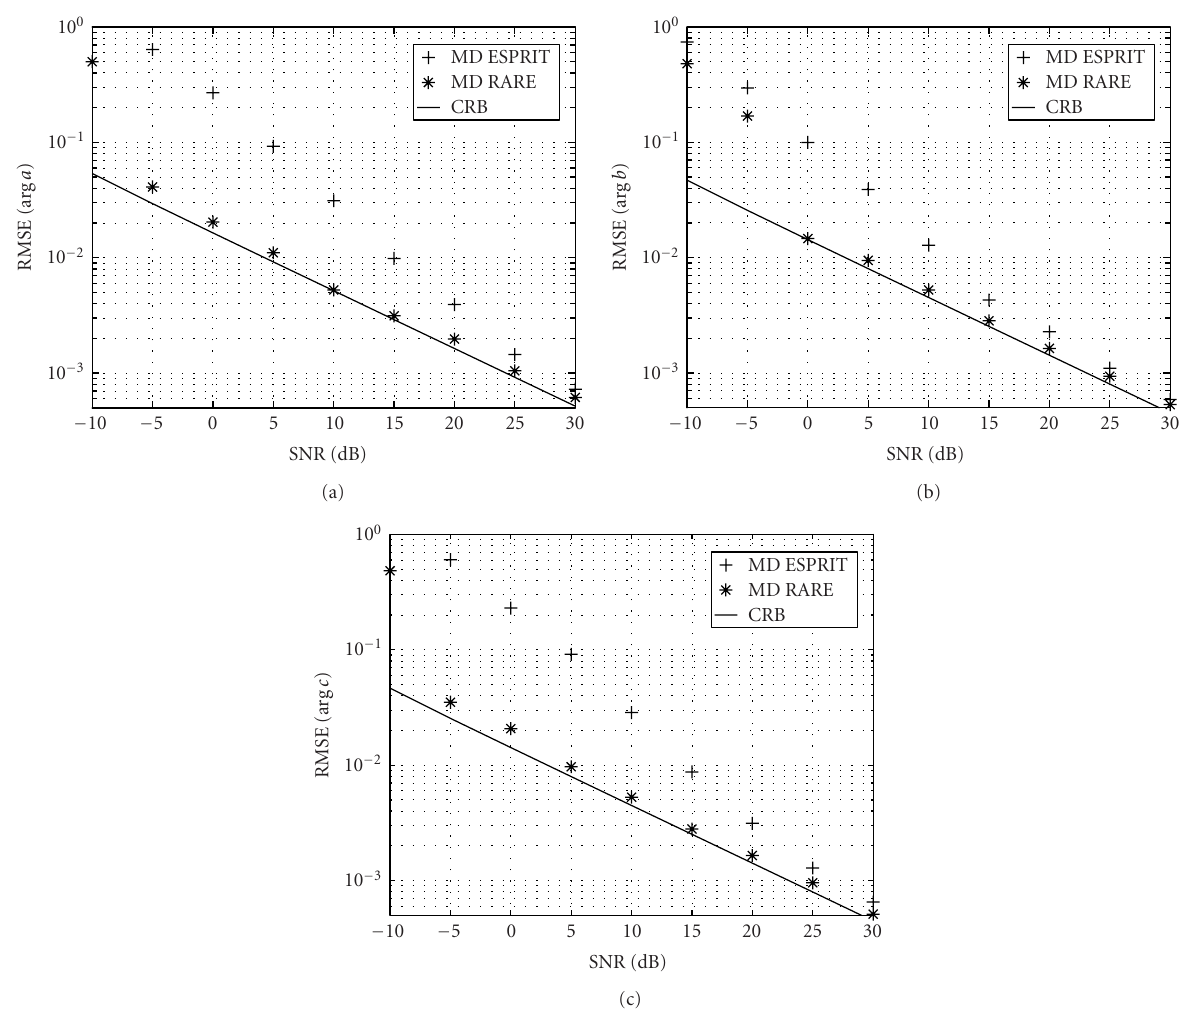
Figure 1: Root mean squared error of 3D RARE versus